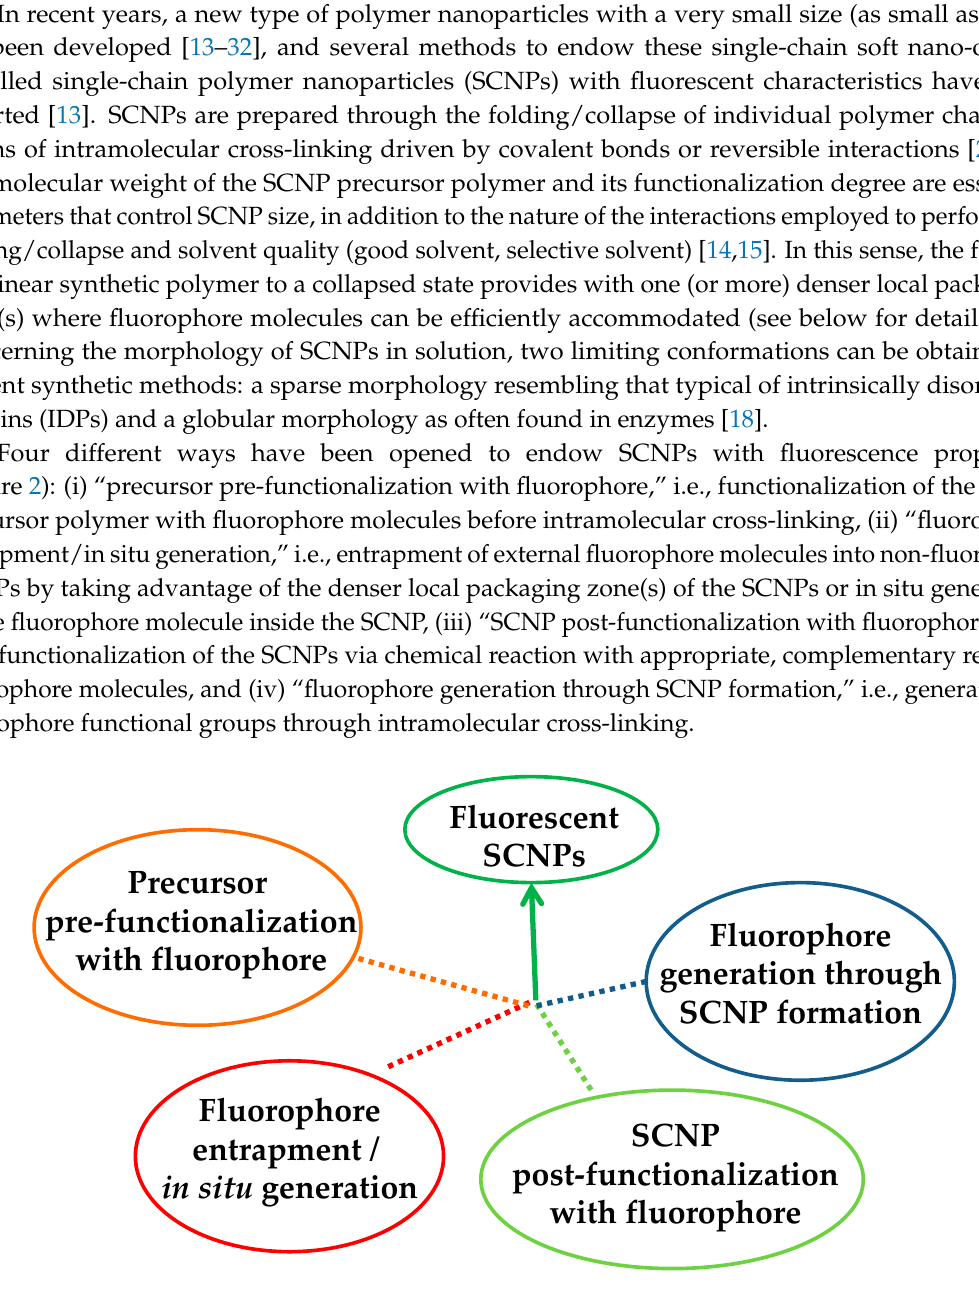
Figure 2. Different strategies developed to endow single-chain nanoparticles (SCNPs) with fluorescent Figure 2. properties.